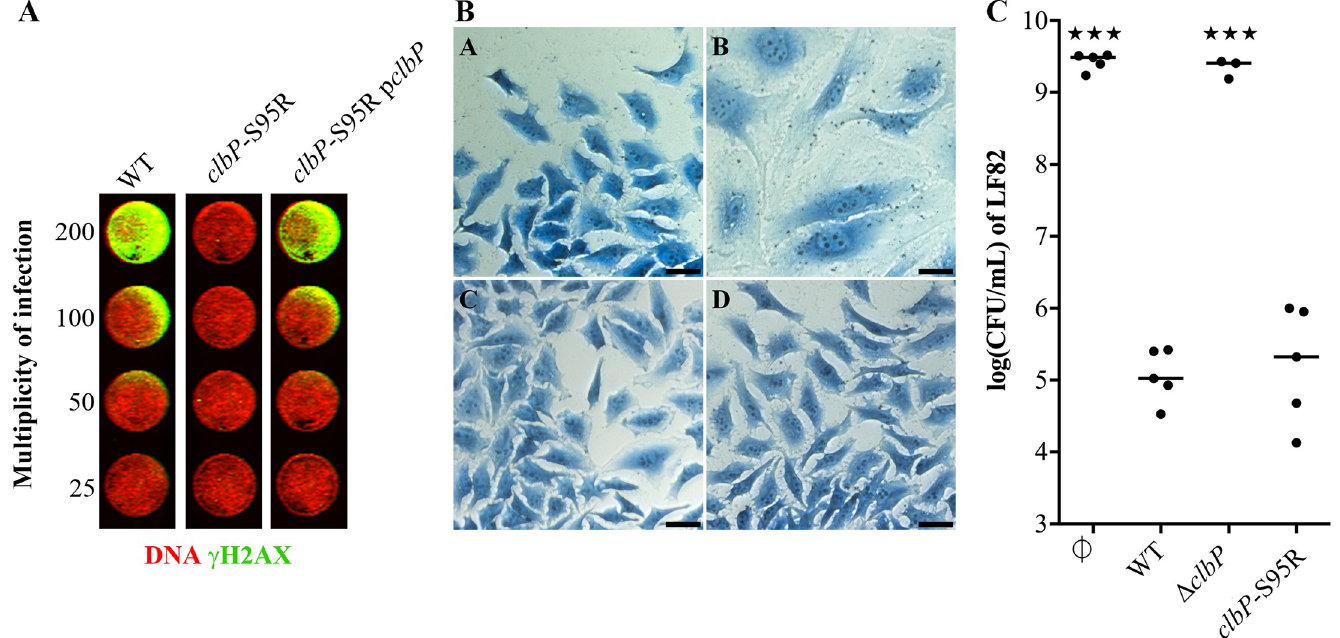
Fig 5. A genomic point mutation that inactivates ClbP catalytic domain abrogates EcN genotoxicity but not the antibacterial activity on LF82. (A) HeLa cells were transiently infected with wild-type E . coli Nissle (WT), a genome edited mutant with a single chromosomal nucleotide change in the clbP gene that inactivates the catalytic site ( clbP -S95R), and the genome edited mutant complemented with the plasmid p clbP . Cells were then fixed, permeabilized and stained with rabbit monoclonal anti-gamma-H2AX followed by an infrared fluorescent secondary antibody (pseudocolored in green). DNA was counterstained with RedDot2. ( B) HeLa cells were transiently infected with wild-type E . coli Nissle (photo B), a clbP gene deletion mutant (C), and the genome edited clbP -S95R mutant (D). These cells were then washed and incubated with gentamicin for 72 hours before staining with Giemsa. The control is shown in photo A. Bars represent 50 μ m. (C) Colony forming unit (CFU) counts of E . coli LF82 following a 24-hour co-culture in M63 medium with wild-type (WT) E . coli strain Nissle 1917 (EcN), the clbP gene deletion mutant ( Δ clbP), and the genome edited mutant with a single nucleotide change in the clbP gene that results in an S95R mutation in the catalytic site ( clbP -S95R). LF82 was also cultured alone as a control ( ∅ ). Medians and individual results of independent experiments are shown. One-way ANOVA and Bonferroni post-tests in comparison with co-culture with WT; $$$ P < 0.001.